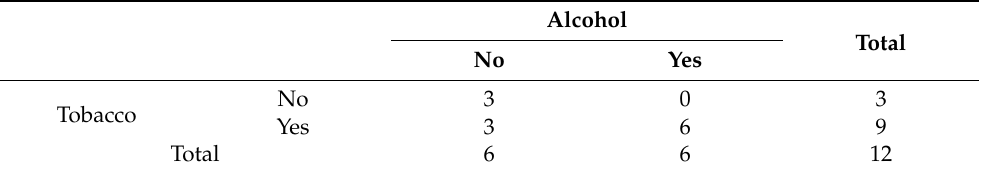
Table 5. Females risk factors crosstab.